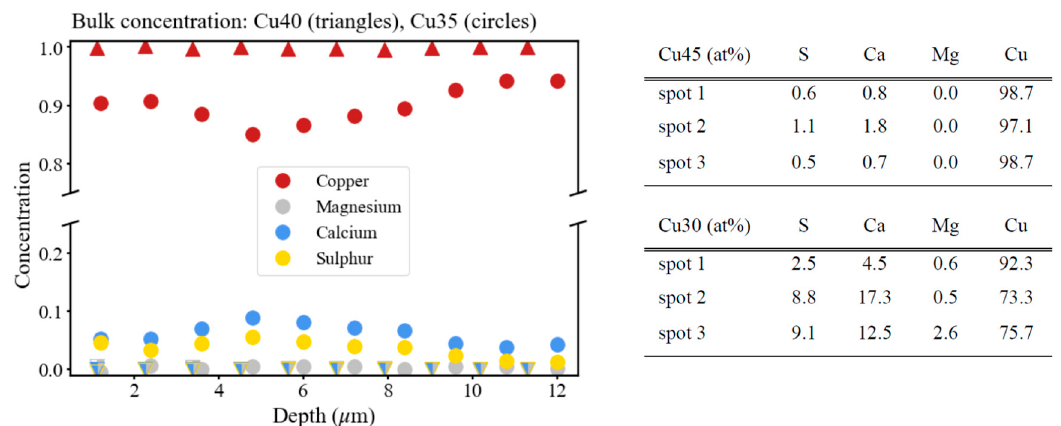
Figure 5. ( Left ) EDS concentrations obtained along the yellow lines in samples Cu40 and Cu35 after the submersion in 0.04 M H 2 SO 4 for 30 min. ( Right ) Concentrations of the yellow spots in samples Cu45 and Cu30 after the submersion in 0.04 M H 2 SO 4 for 30 min. (See Figure 4).